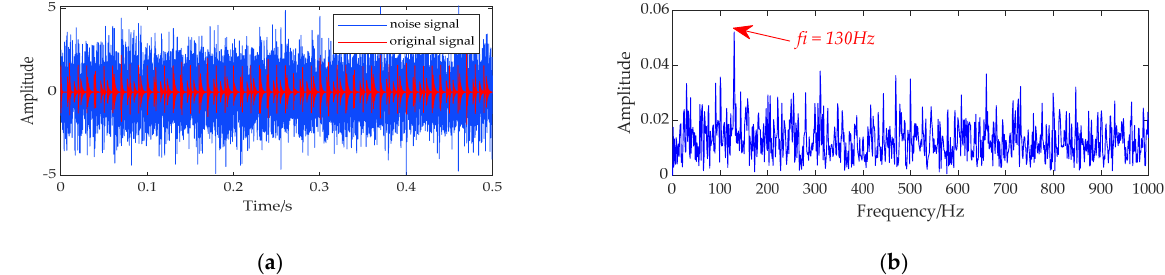
Figure 5. Time-domain waveforms ( a ) and envelope spectrum ( b ) of simulation signal . ( a ) Time- domain waveform. ( b ) Envelope spectrum.